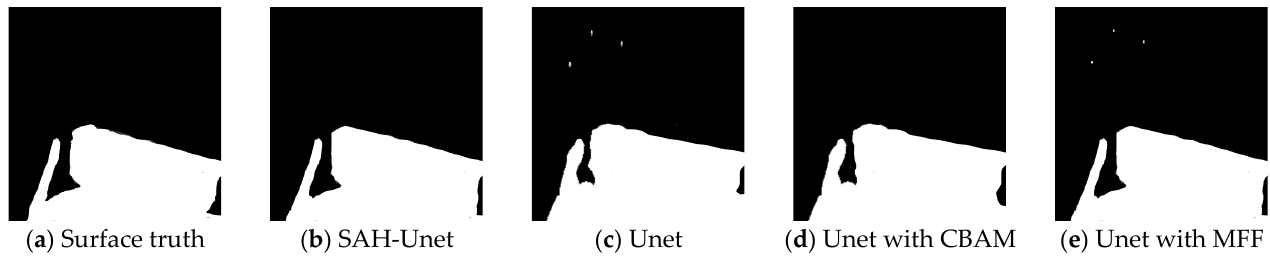
Figure 11. Impervious Surface Data Extraction Results of Different Unet Architectures.